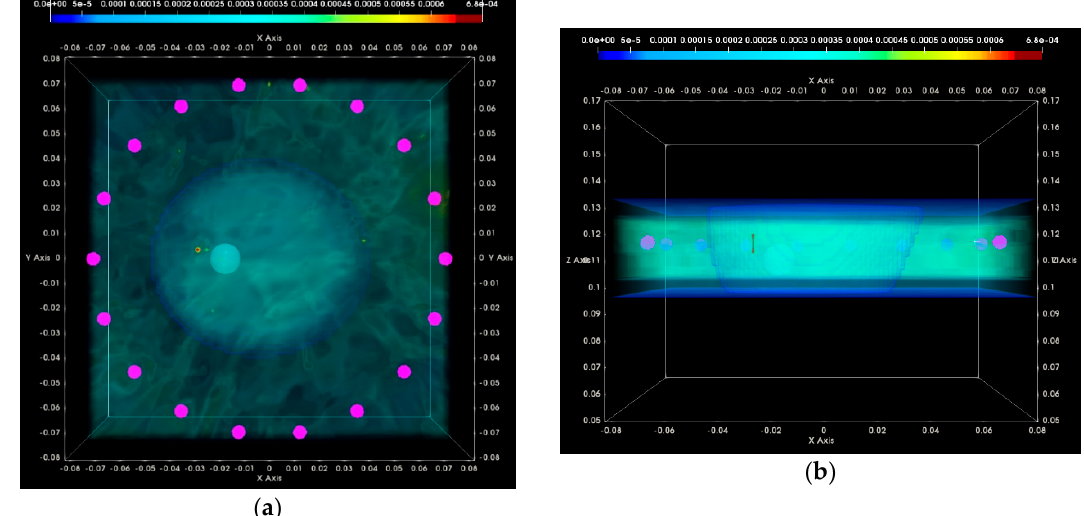
Figure 27. Breast rotational position #2—Test Date 1—image formed using six vertical positions of the sensor network, in the vicinity of the tumor—image in the interior of the breast superimposed with the image of the full imaging domain: ( a ) top XY view; ( b ) side XZ view. Table 4. QA Metric 4, Evaluated for the Four Analyzed Test Datasets.